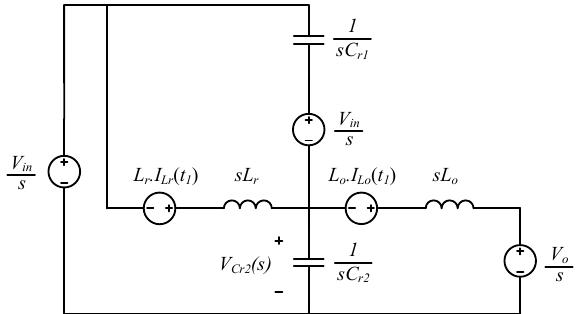
Figure 11. Equivalent circuit of the resonant period ( t 1 – t 2 ).